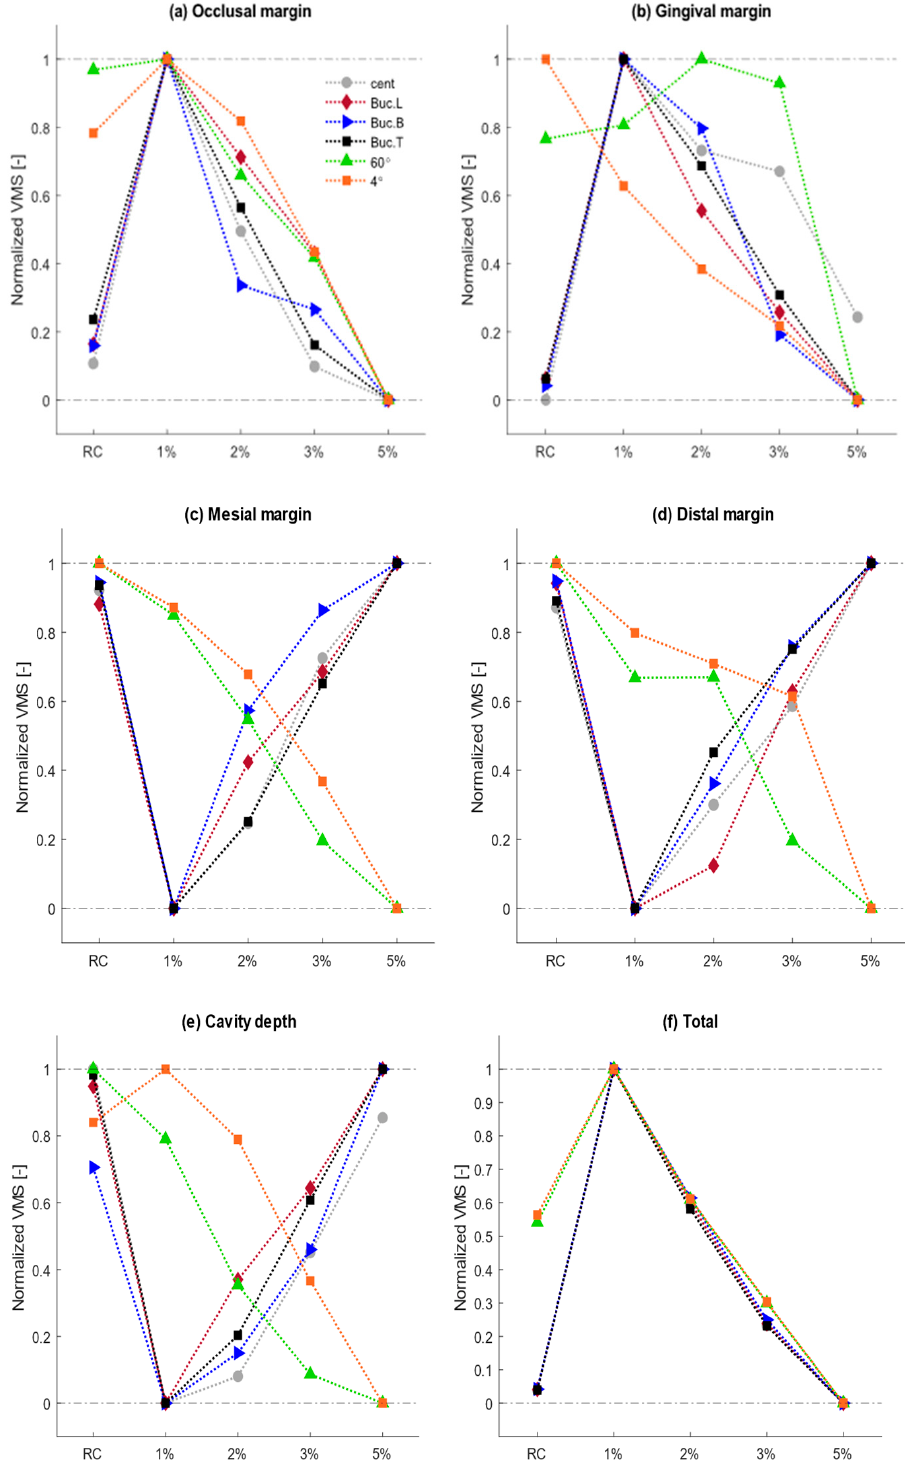
Figure 3. Normalized changing trend of VMS values created among various incorporation ratios of ZnO NPs in various boundary